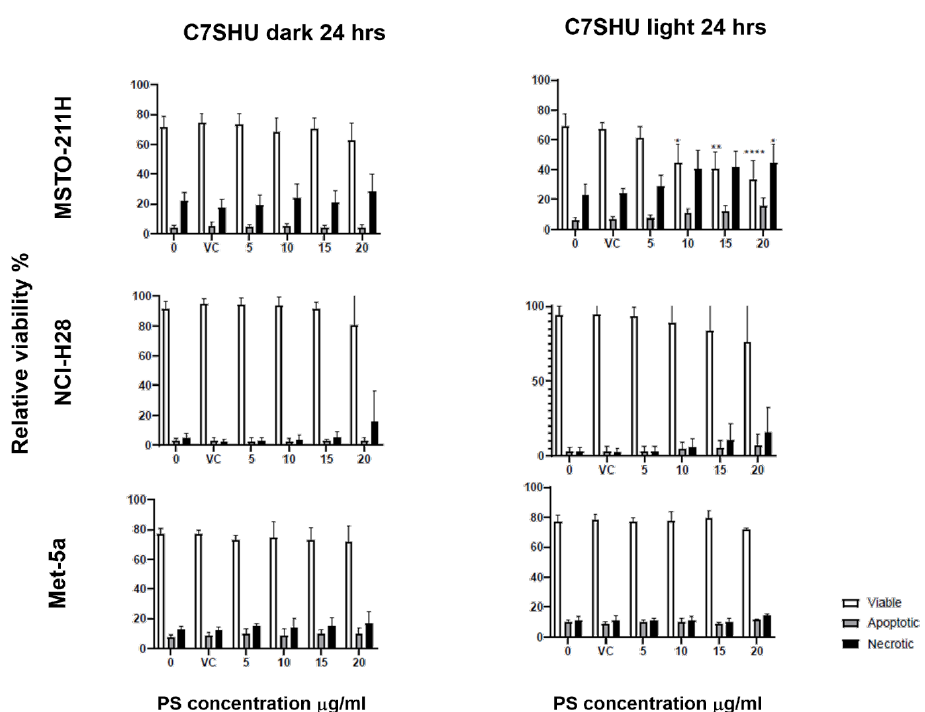
Figure 11. Cell death analysis of C7SHU-treated MSTO-211H, NCI-H28, and Met-5a cells as deter- mined by the Annexin V-FITC/PI assay 24 h after treatment. Results are expressed as the mean ± SD of three independent experiments. The varying significance of viable populations relative to that of the untreated control are indicated by * ( p ≤ 0.05), ** ( p ≤ 0.01), *** ( p ≤ 0.001), and **** ( p ≤ 0.0001).